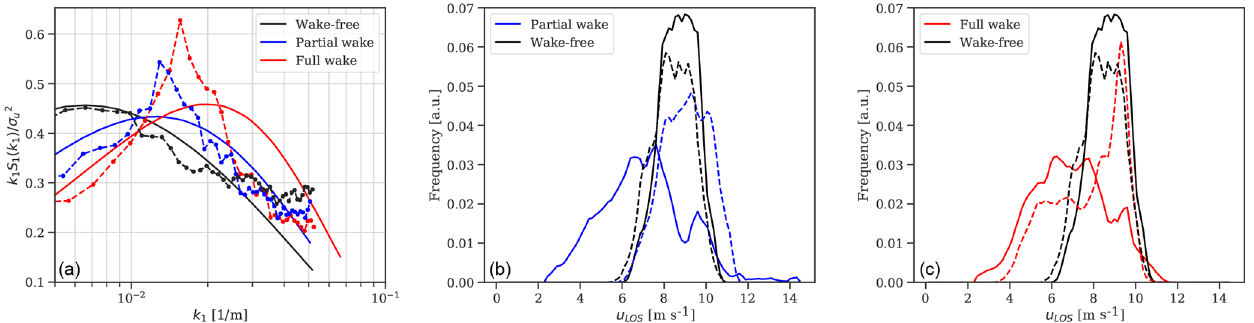
Figure 7. (a) Comparison of the normalized ensemble-average u LOS spectrum based on measurements with the central beam of the PL lidar (dashed line and markers) against the fitted theoretical Mann spectra using Eq. (11) (solid line). (b, c) Normalized ensemble-average Doppler spectrum measured over a 10min period by the CW lidar using bins b3 (solid line) and b8 (dash line).